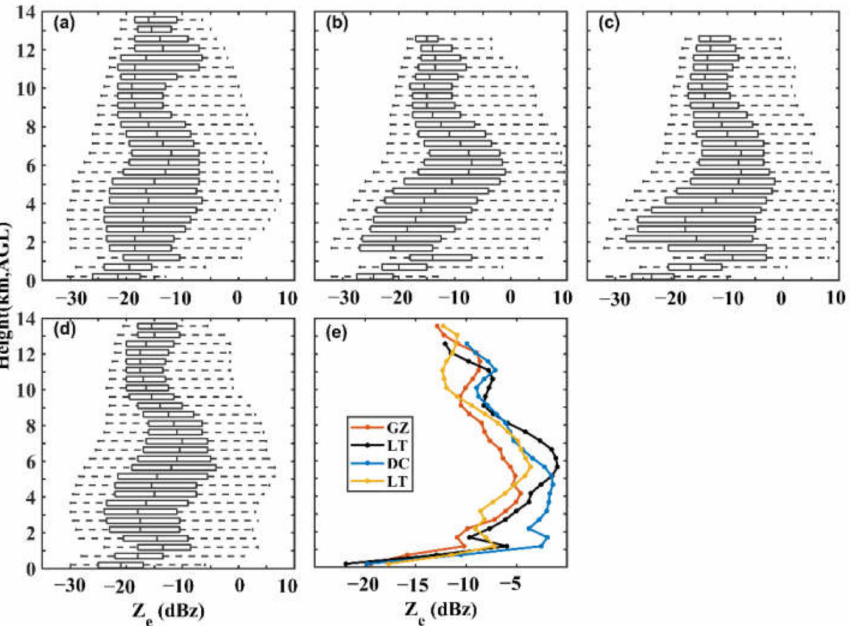
Figure 6. Vertical distributions of the radar reflectivity factor ( Z e ) at four sites. In box and whisker plots, the left and right lines of each box represent the 25% and 75% values, respectively, and the gray solid line inside the box indicates the median position. ( a ) GZ; ( b ) LT; ( c ) DC; ( d ) JL; ( e ) mean values of Z e